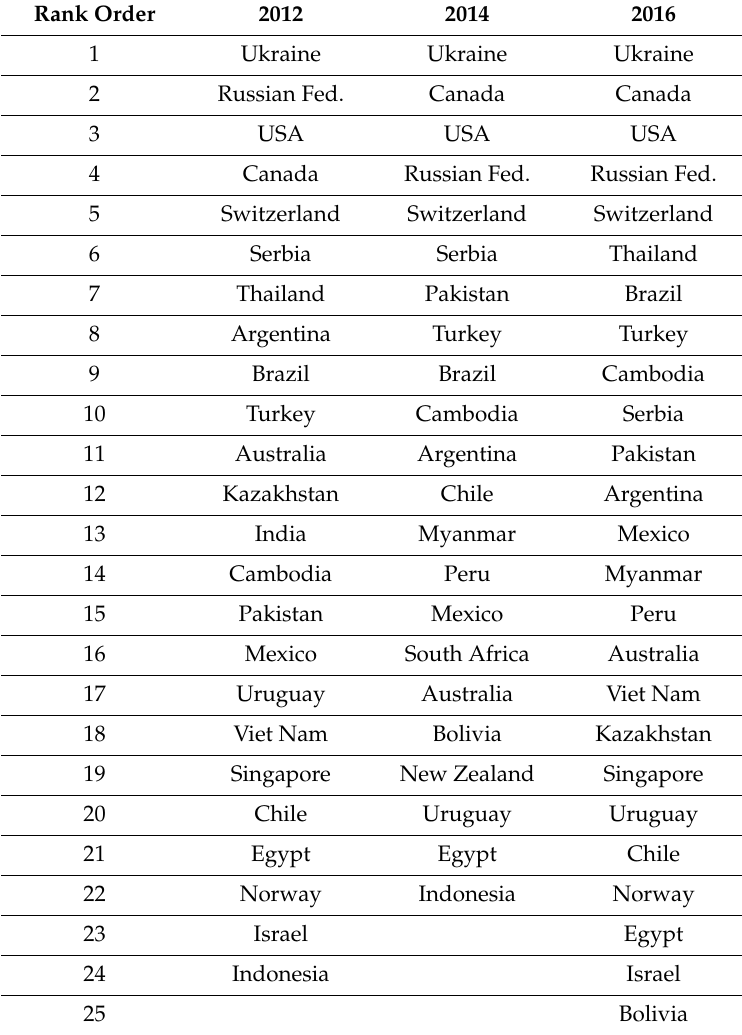
Table 3. Ranking of suppliers of cereals to the EU according to their volume exported. Rank Order